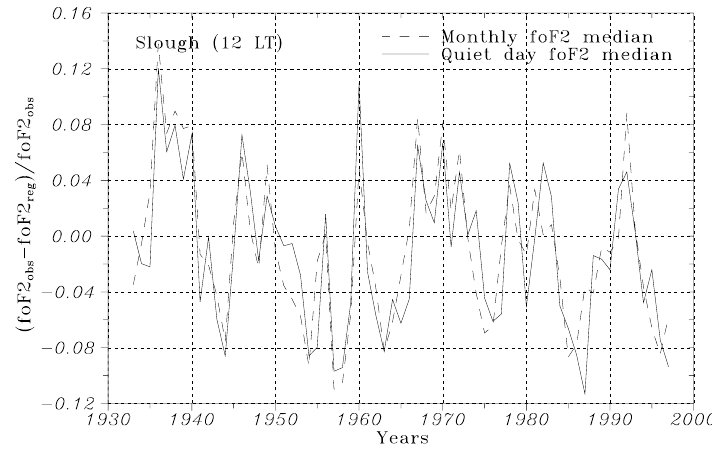
Fig. 1. A comparison of annual mean δ fo F2 variations at Slough (12:00LT) when the usual monthly median and Q - median fo F2 values are used in the cal-